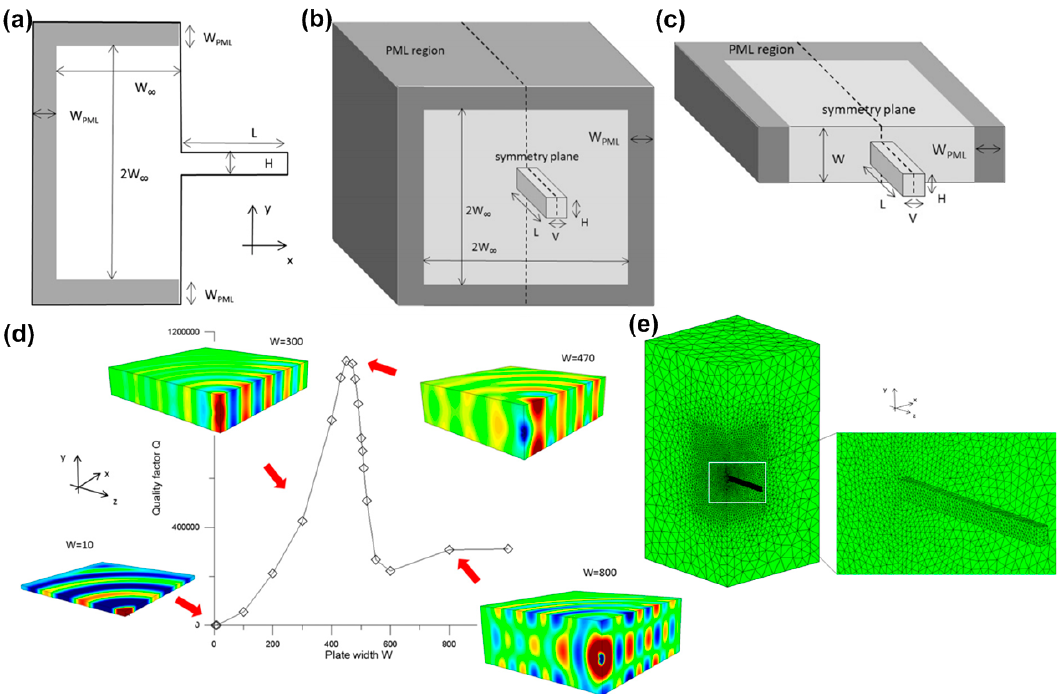
Figure 2. Evaluation of anchor loss in a cantilever structure using numerical analysis: ( a ) implementation of perfectly matched layers (PML) for a 2D cantilever; ( b ) implementation of PML for a 3D cantilever with a semi-infinite substrate; ( c ) implementation of PML for a 3D cantilever with a plate substrate; ( d ) computed values of Q anchor ; ( e ) mesh adopted for the 3D cantilever and semi-infinite substrate. This figure is reproduced from [80] (© 2013 Elsevier).